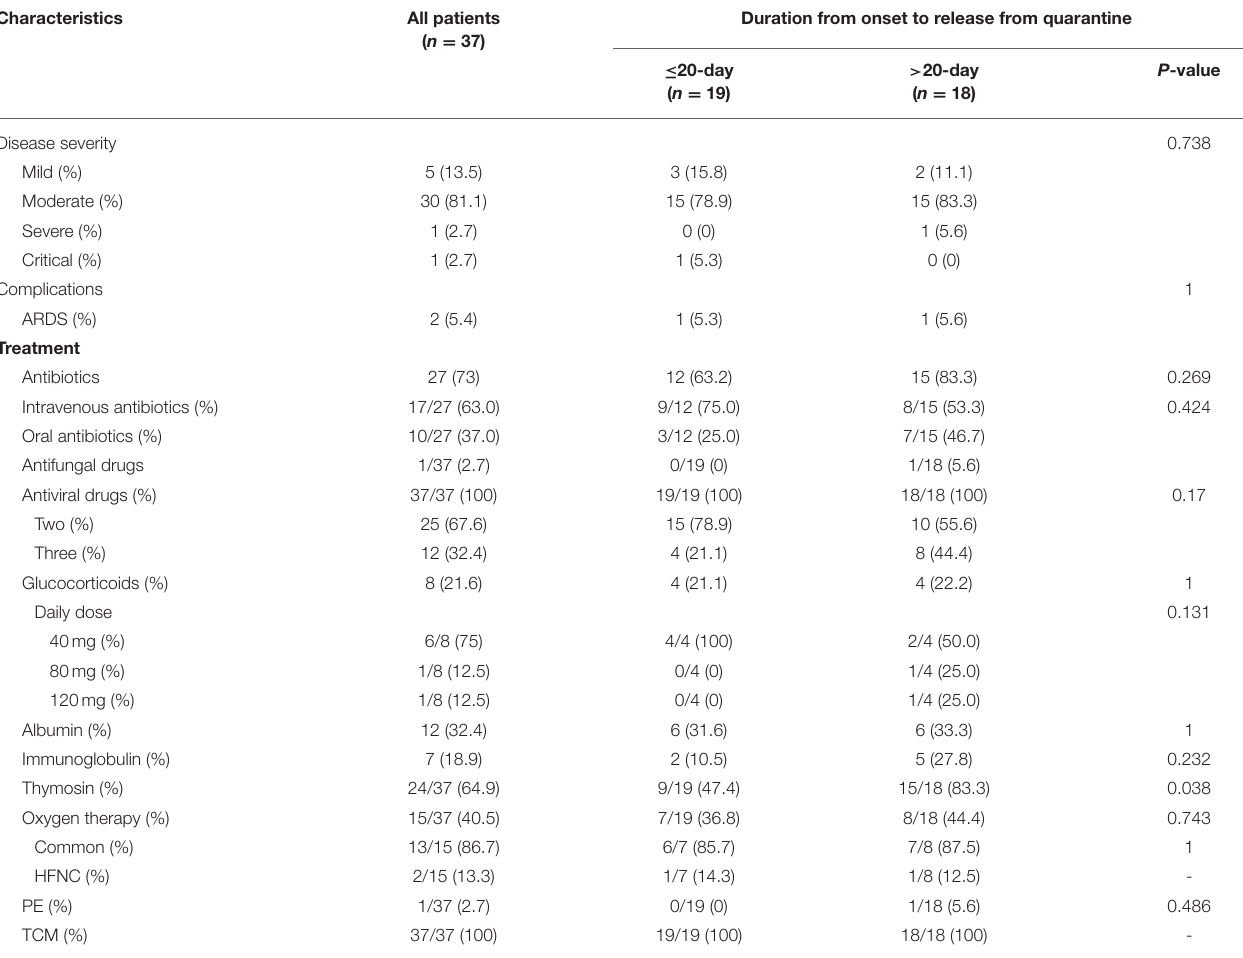
Duration from onset to release from quarantine ( n = 37) > 20-day ≤ 20-day ( n = 19)